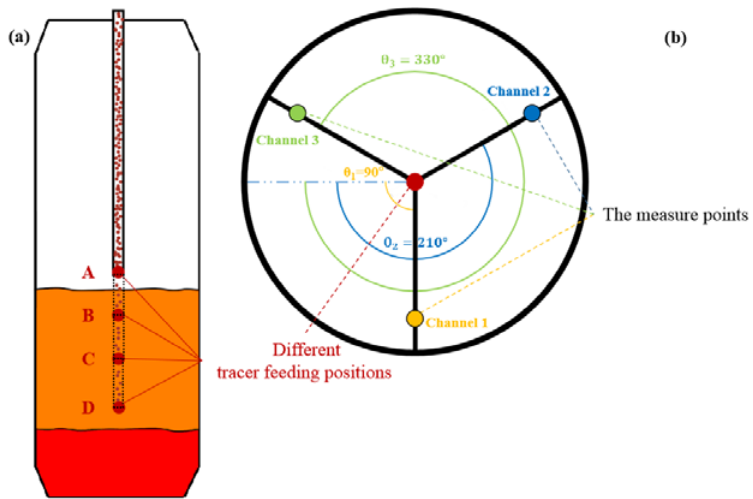
Figure 4. Di ff erent tracer feeding positions ( a ), and the position and angle of the sensor and tracer ( b ).